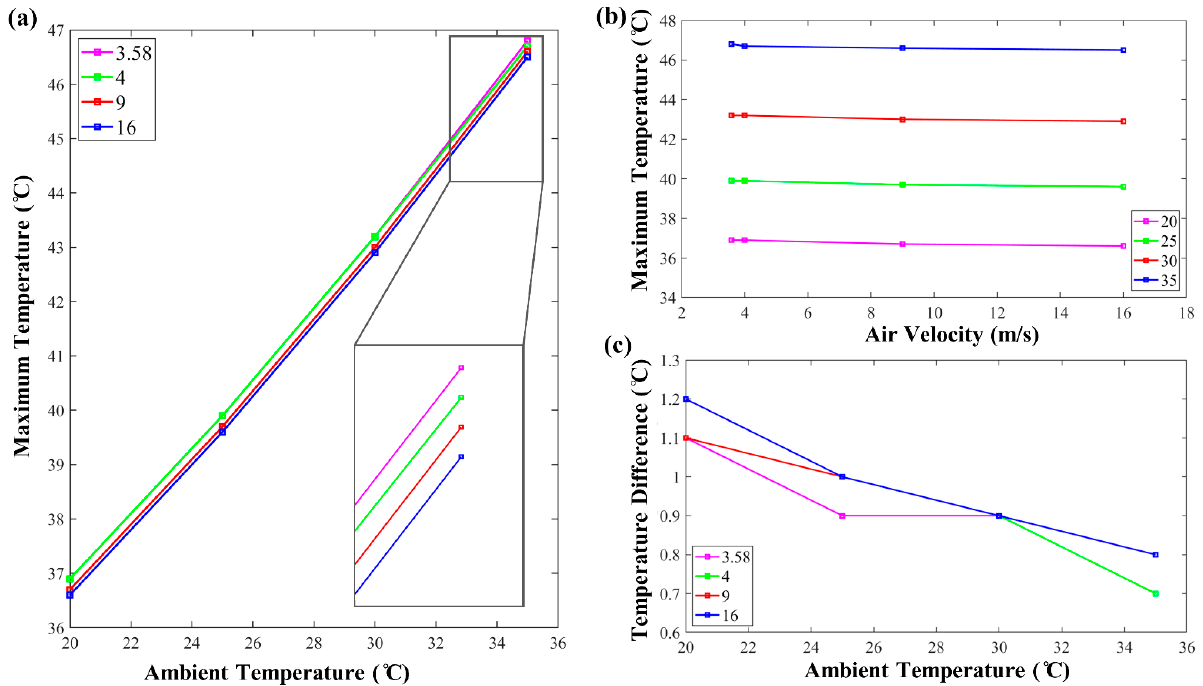
Figure 5. The profile of maximum temperature ( a ) and temperature difference ( b , c ) under various operation conditions.